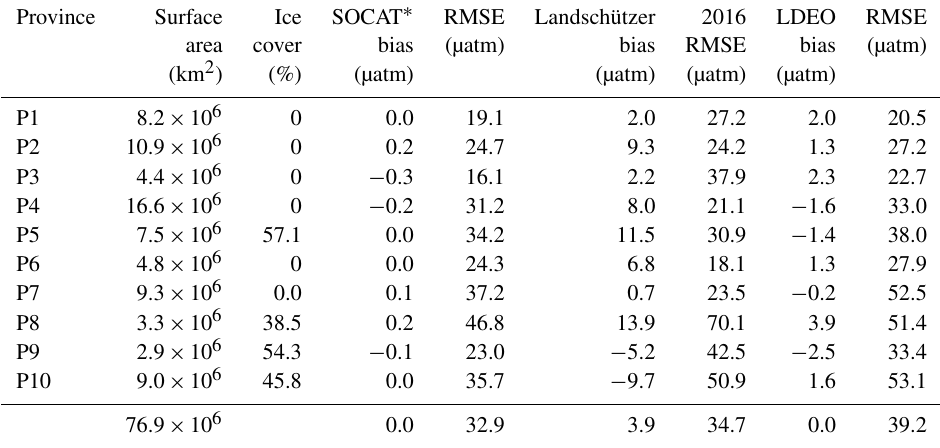
Table 3. Root mean square error between observed and calculated p CO 2 in the different biogeochemical provinces. The SOM-FFN results are compared to data extracted from the LDEO database (Takahashi et al., 2014) and the overlapping cells from the Landschützer et al. (2016) p CO 2 climatology.